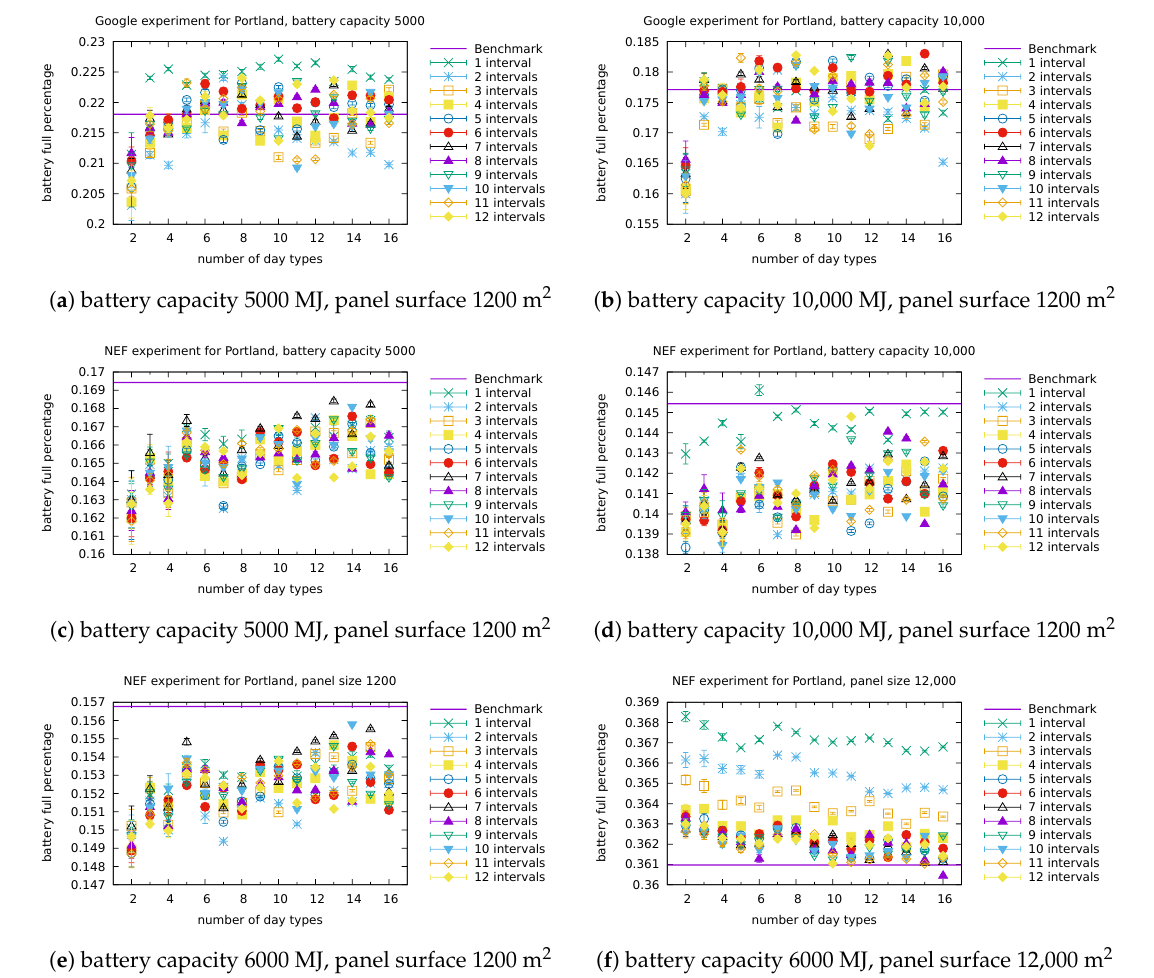
Figure A3. Full ratio, Portland: Detailed performance of our model for several settings of the battery capacity and panel surface with Google consumer ( a , b ) and NEF consumer ( c – f